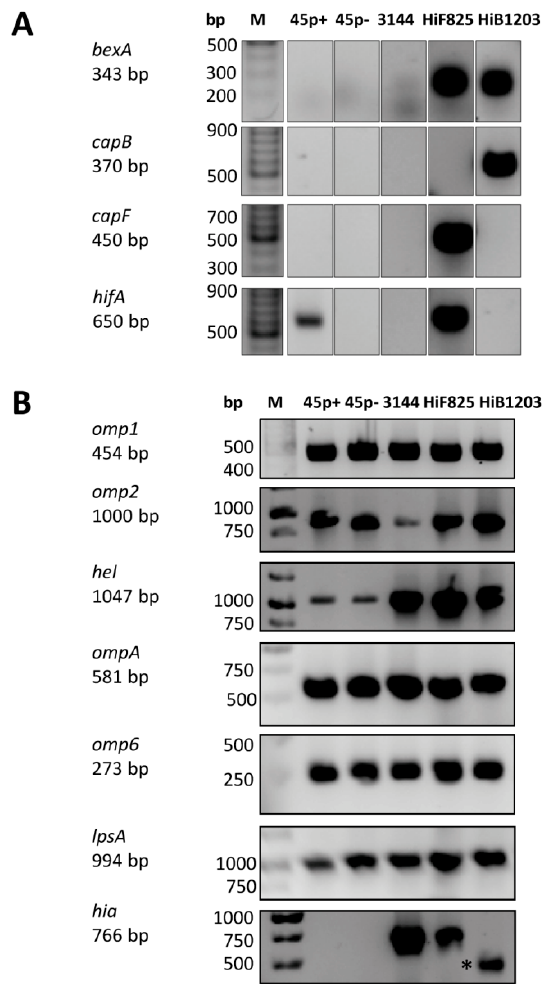
Figure 1. Genomic analyses of the indicated bacterial strains. ( A ) Verification of bacterial strains due to presence of the serotyping capsule gene ( capB and capF ), the bexA gene responsible for the polysaccharide export to the cell surface and the hifA gene enabling isolates to express fimbria. ( B ) Analysis for presence of genes for expression of several virulence factors such as outer membrane proteins ( omp1, omp2, hel, ompA and omp6 ), adhesin ( hia ) and the glucosyltransferase ( lpsA ). PCR was performed as described in material and methods and the corresponding oligonucleotide primers are shown in Table 1. A truncated amplification product was generated with DNA from HiB1203 and is marked with an asterisk (*). Varying band intensity is due to non-standardized amounts of genomic DNA template. bp, base pairs.